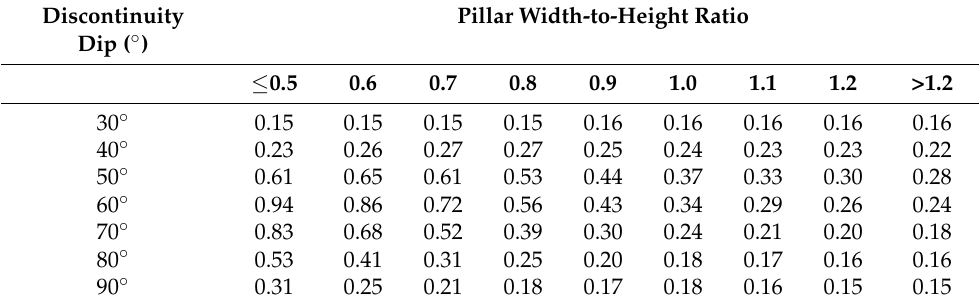
Table 2. Frequency factor ( FF ). Extracted from [18]. Average Frequency of Large Discontinuities per